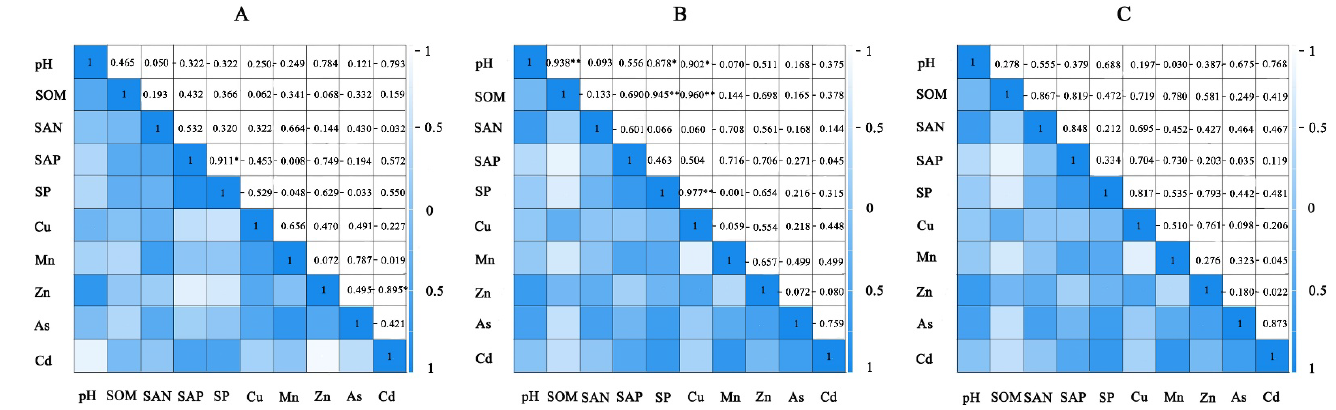
Figure 5. Correlation between the physical and chemical properties and the heavy metal content of the soil.